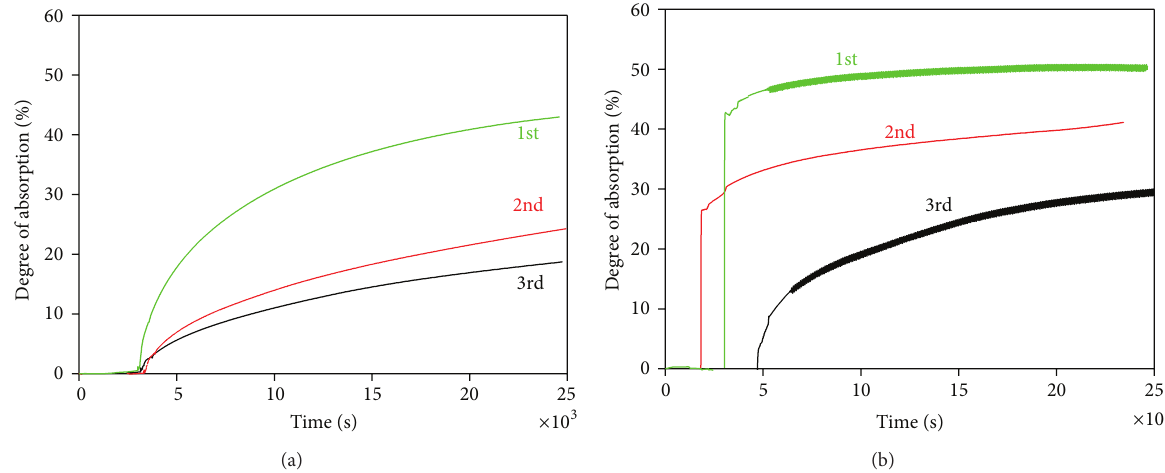
Figure 8: Cyclic degrees of absorption tests. (a): dolomite pyrolysis products calcined in Ar atmosphere; (b): calcined in vacuum.